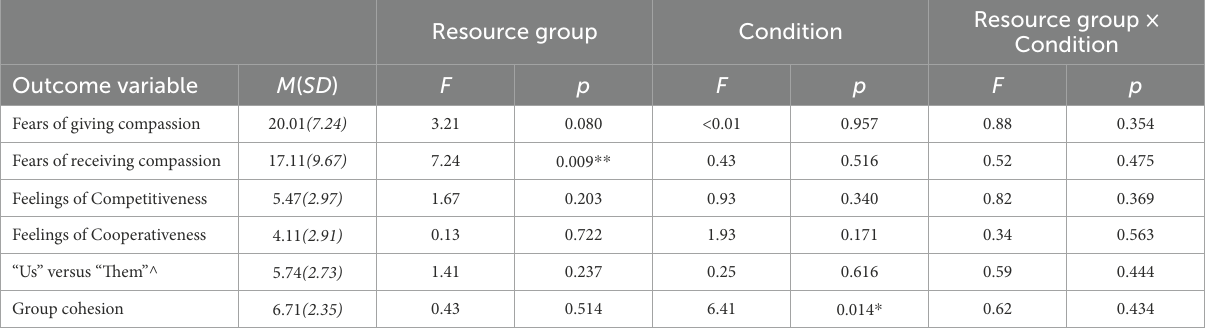
TABLE 3 Linear mixed models for Study 2 exploring the effect of condition and resource group on fears of compassion, as well as group dynamics and cohesion. Resource